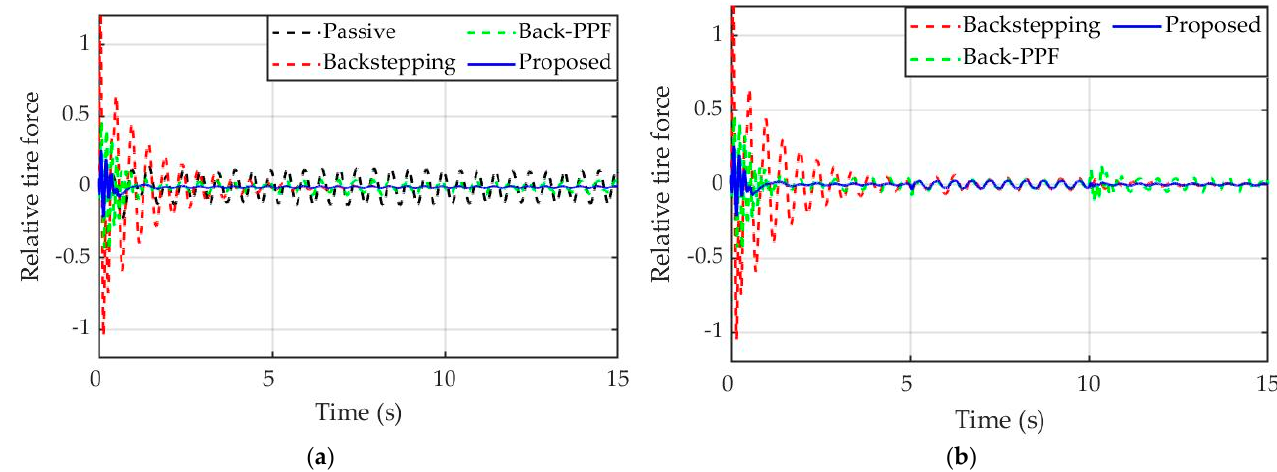
Figure 8. Relative tire force responses: ( a ) Non-fault; ( b ) Actuator-fault.